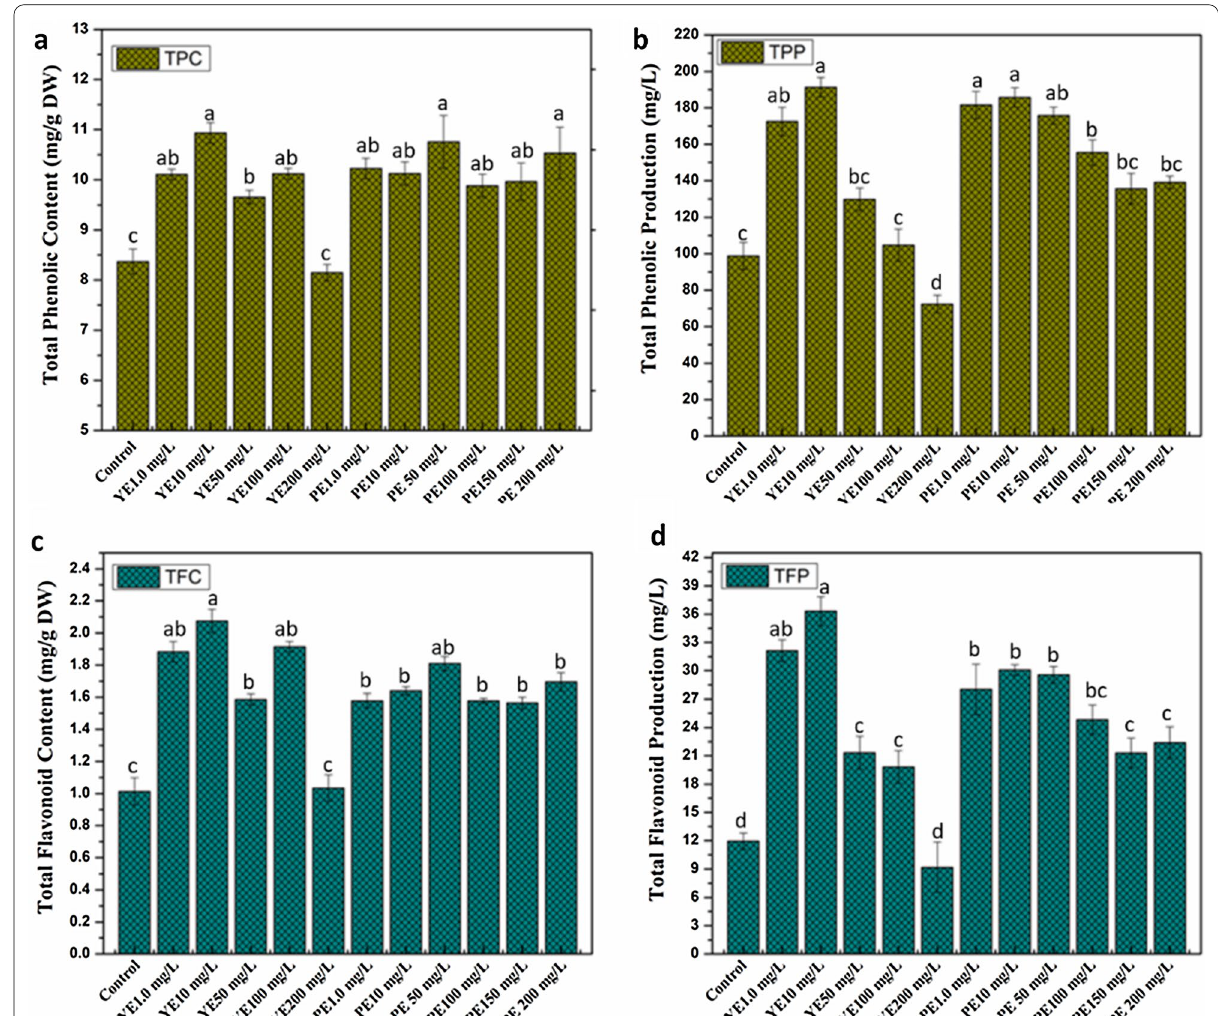
Fig. 4 Impact of yeast extract (YE) and pectin (PE) on: a Total phenolic contents (TPC), b Total phenolic production (TPP), c Total flavonoid contents (TFC), d Total flavonoid production (TFP). Values represent means at p <